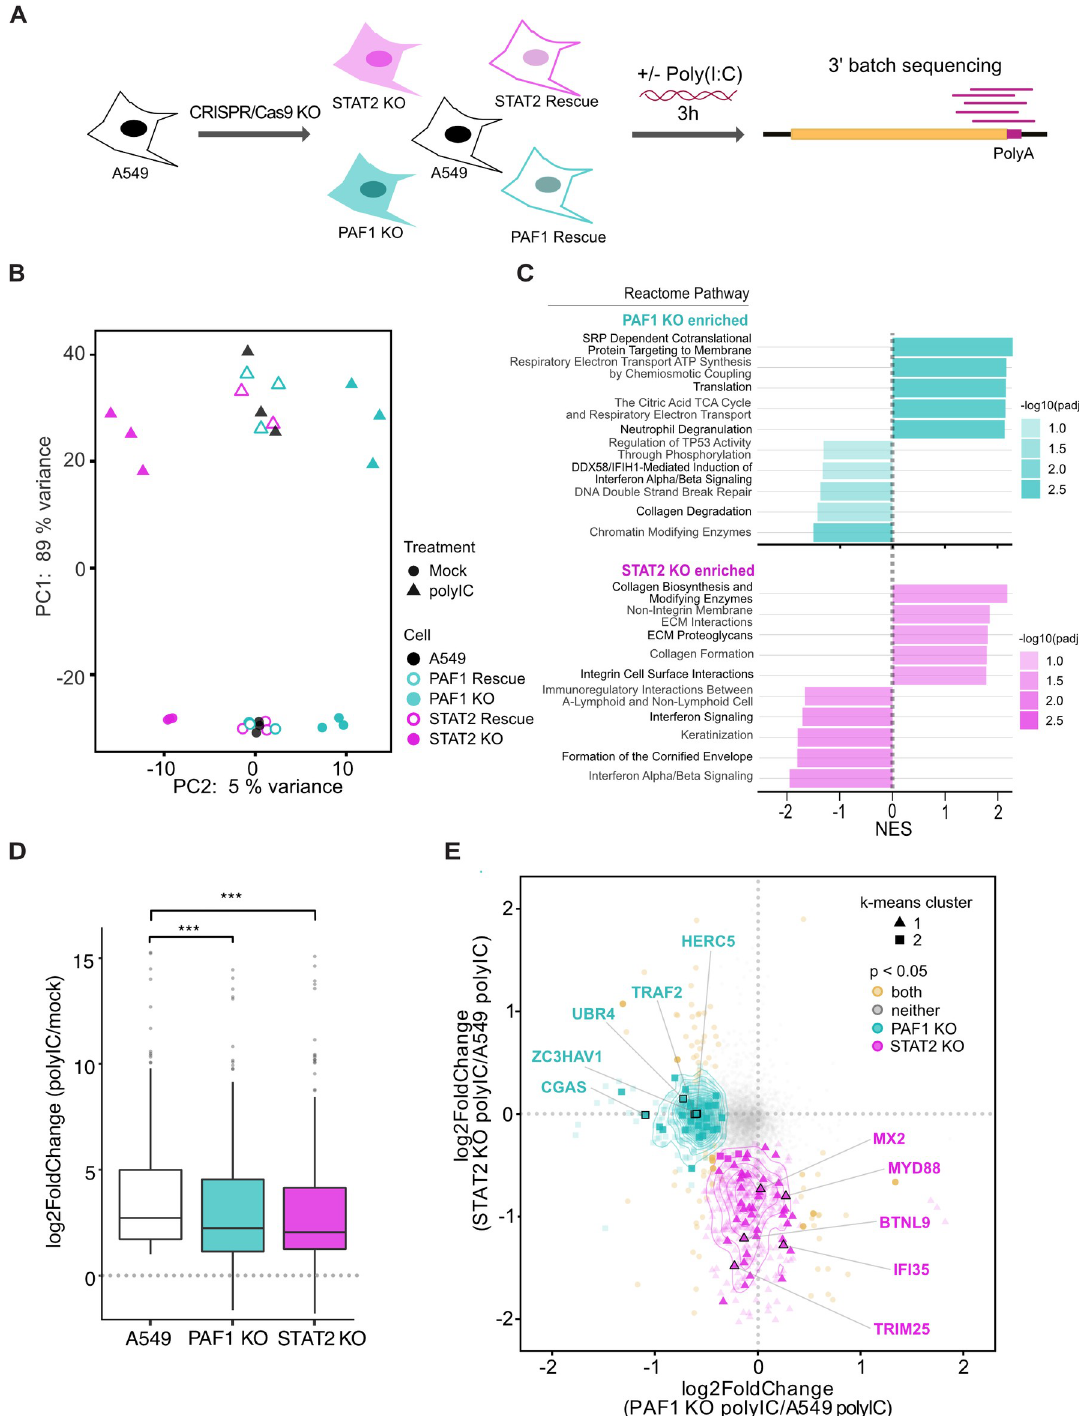
Fig 2. PAF1 is required for expression of a subset of genes activated by poly(I:C). (A) Parental A549, PAF1 KO/rescue and STAT2 KO/rescue cells were stimulated with poly(I:C) for 3 hours and subjected to RNA-seq and DESeq2 differential gene expression analysis. Results are based on three independent biological replicates. (B) Principal component analysis performed on all samples showed a clear separation between principal components (PC) describing untreated/treated cells and cell genotype. (C) GSEA was performed on genes differentially expressed in KO cells compared to parental A549 cells following poly(I:C) treatment. Up to the top 5 positively and negatively enriched Reactome pathways were plotted for each comparison (p adj < 0.1). A full list of GSEA results is available in S2